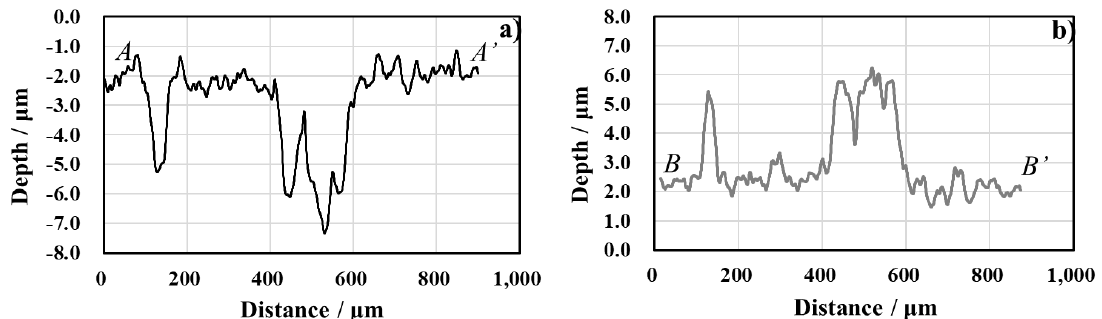
Figure 12. Measured surface roughness profiles by three-dimensional laser profilometer. ( a ) Surface roughness along A –A’ in Figure 9b, and ( b ) surface roughness along B –B’ in Figure 10b.